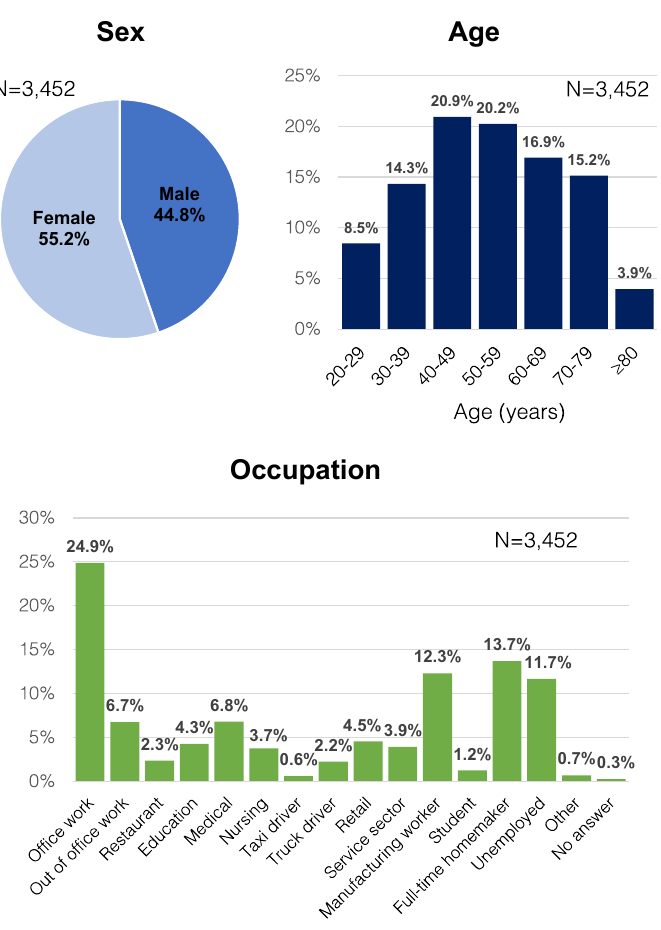
Fig. 2 Characteristics of residents who participated in at least one round of the study (N = 3,452) Distribution of sex, age, and occupational characteristics of the residents who participated at least once in all three rounds of this study. Females (55.2%), o ffi ce workers (24.9%), and residents in their 40s (20.9%) were the most